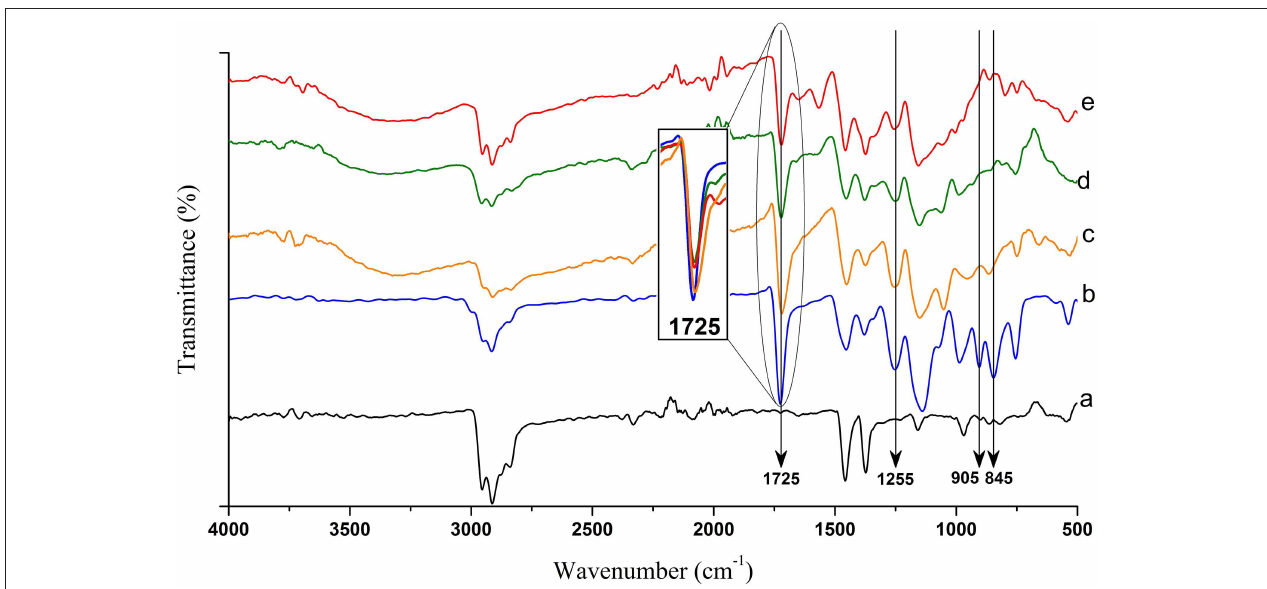
FIGURE 5 | FTIR spectra of pristine s-PP nanofibers (a) compared with 300% grafted nanofibers (b) and fibers aminated with EA (c), DEA (d), and TEA